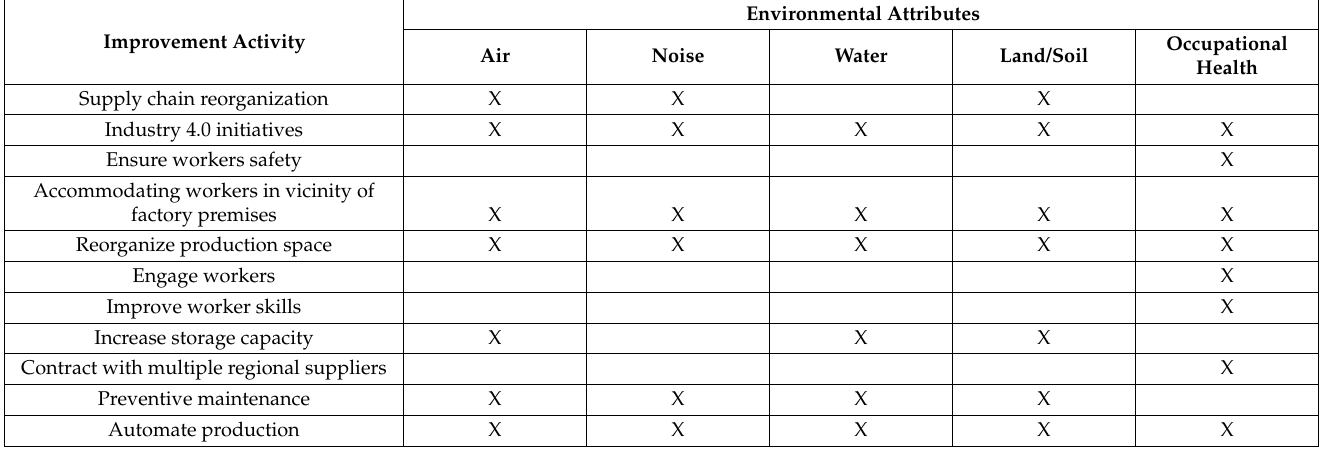
Table A4. Environmental assessment identification